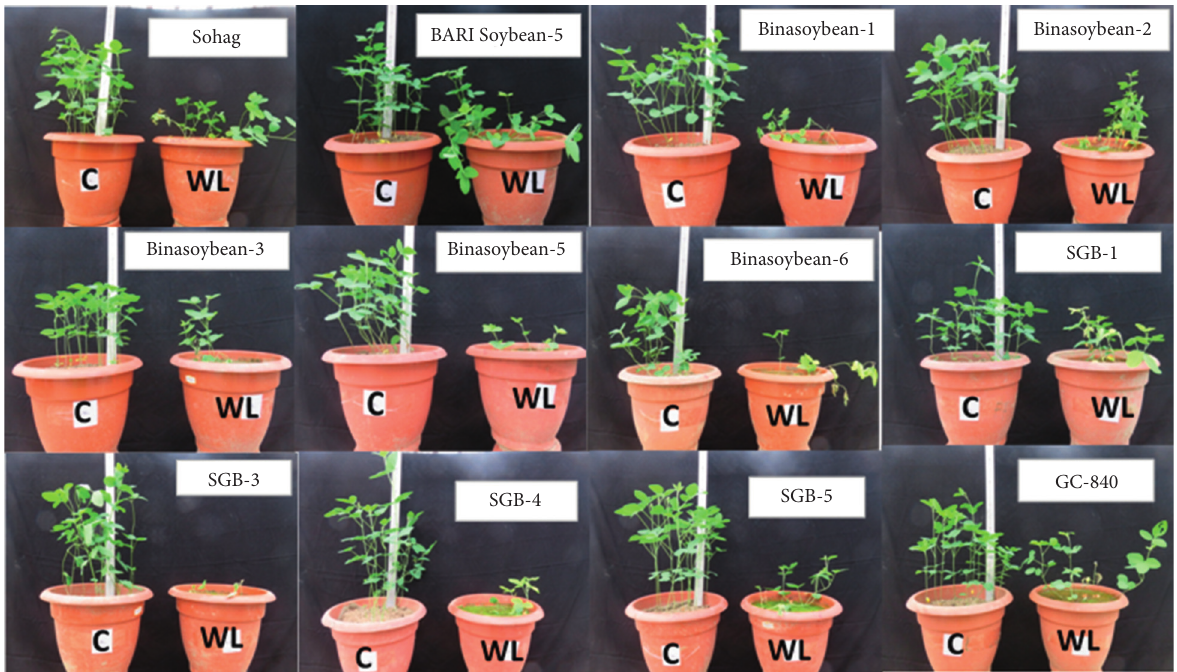
Figure 7: Phenotypic variations of soybean under waterlogged and control condition at 25 DAS. Here, C denotes control and WL waterlogged plants.